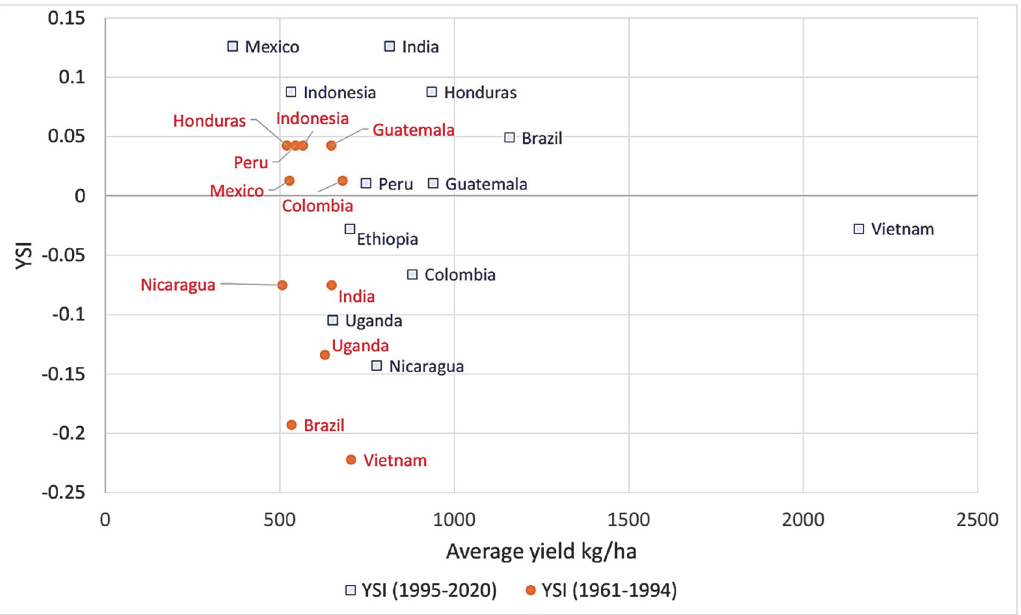
Figure 7. Comparison of YSI and average yield in 1961–1994 and 1995–2020. Source: authors’ own construction.